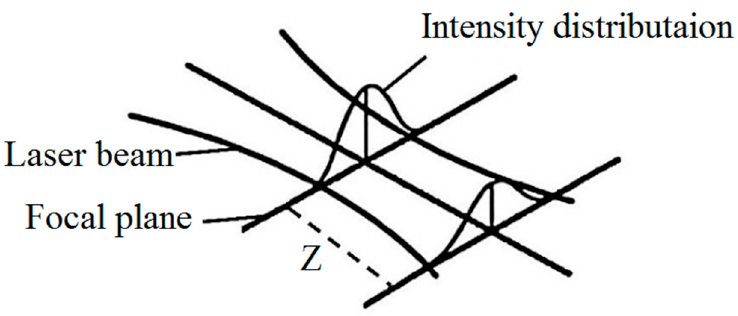
Figure 5. Schematic of laser beam Gaussian distribution [35].